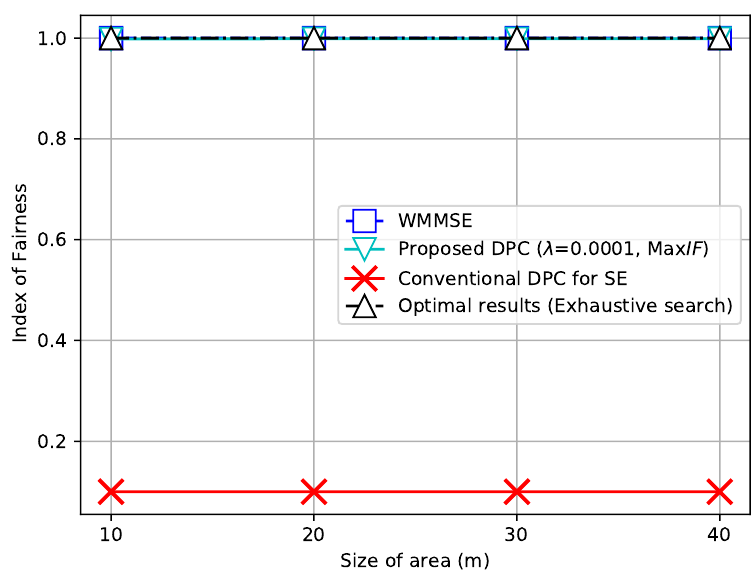
Figure 12. Index of fairness of the conventional and proposed schemes for α = 3.8 in Nakagami- m fading channels when m =